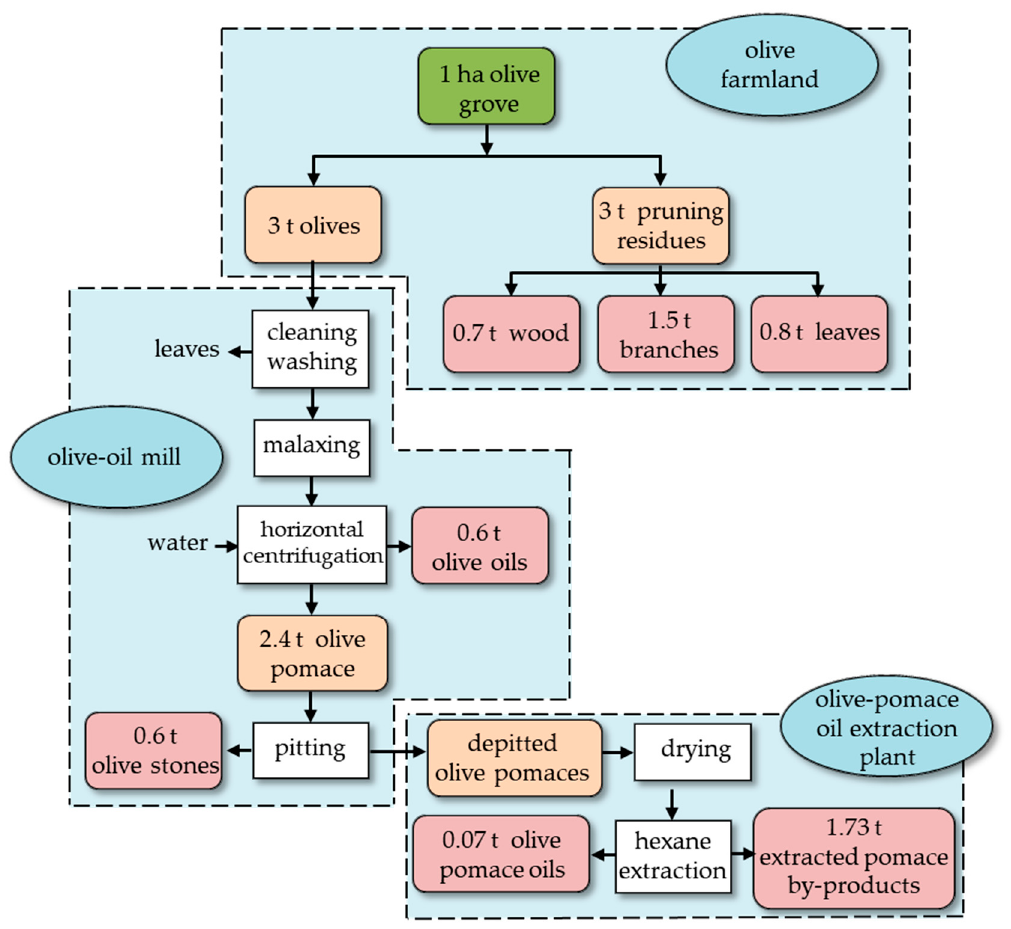
Figure 4. By-products obtained from olive orchards and olive mills.